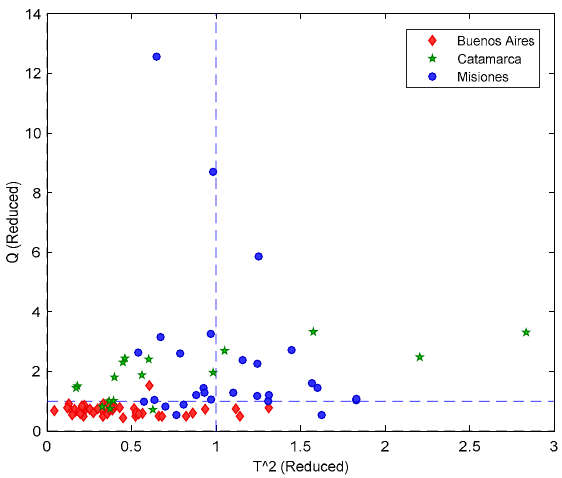
Figure 3. SIMCA modelling on FT-MIR data. Projection of HN2017 objects onto the T 2 (reduced) vs. Q (reduced) model space of class BA.